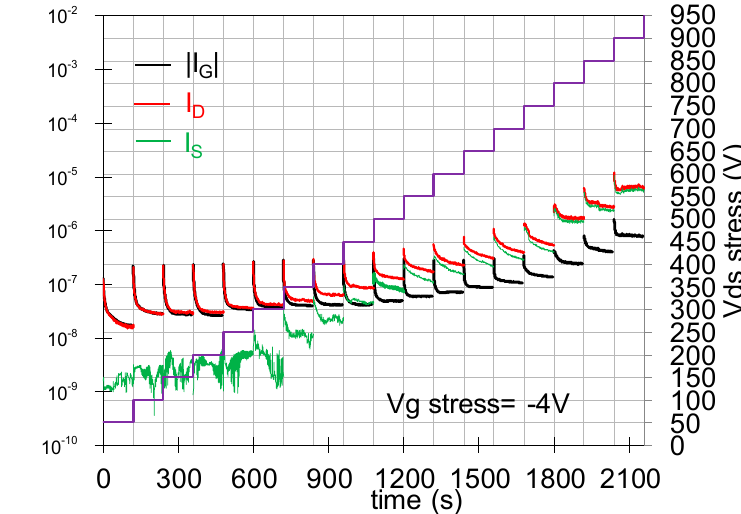
Figure 13. Results of a step-stress experiment carried out on a transistor with L GD = 15 μ m. During stress, V GS = − 4 V and the drain voltage is increased by 50 V every 120 s.